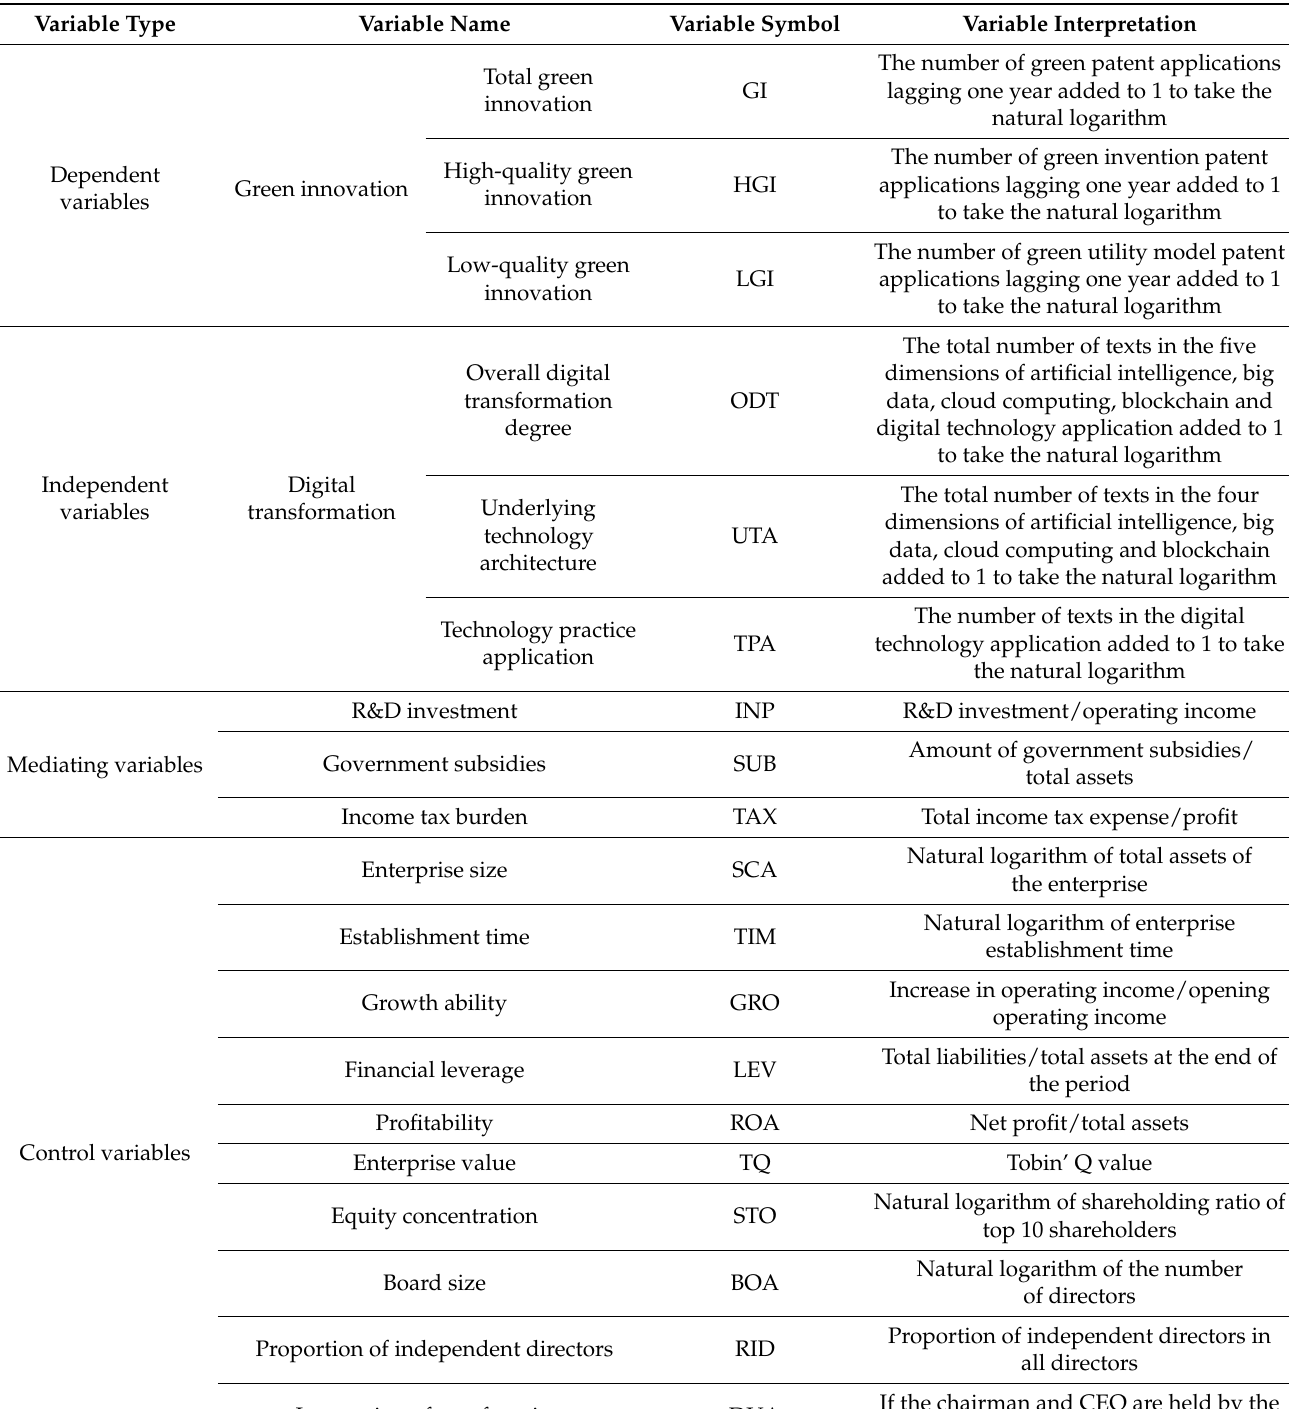
Table 1. Definition of main